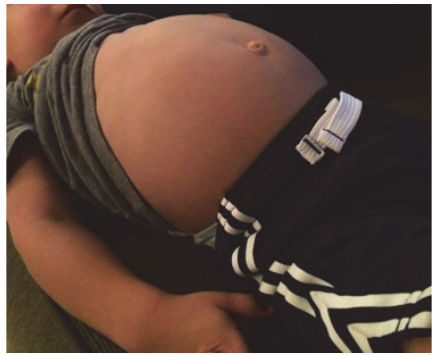
Figure 1: Photograph of severe abdominal distention in the 2-year-old male presented in Case 1.